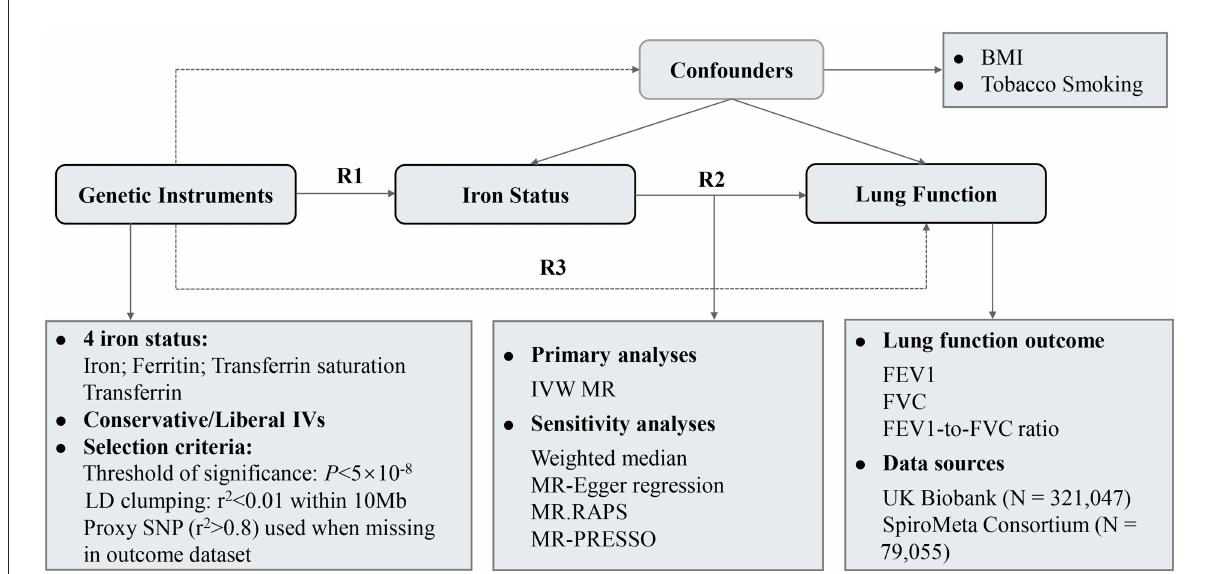
FIGURE1 Study design and overview of the MR study. Summary-level GWAS statistics from participants of European descent were used in present study. R 2 represents the causal effect estimates of iron status on spirometric function, calculated using formula R 2 = R 3/ R 1. R1 and R3 denote the direct relations of genetic instruments on iron status and spirometric function (FEV1, FVC, and FEV1/FVC ratio), respectively. BMI, body mass index; FEV1, forced expired volume in 1s; FVC, forced vital capacity; GWAS, genome-wide association study; IVs, instrumental variables; IVW, inverse variance weighted; LD, linkage